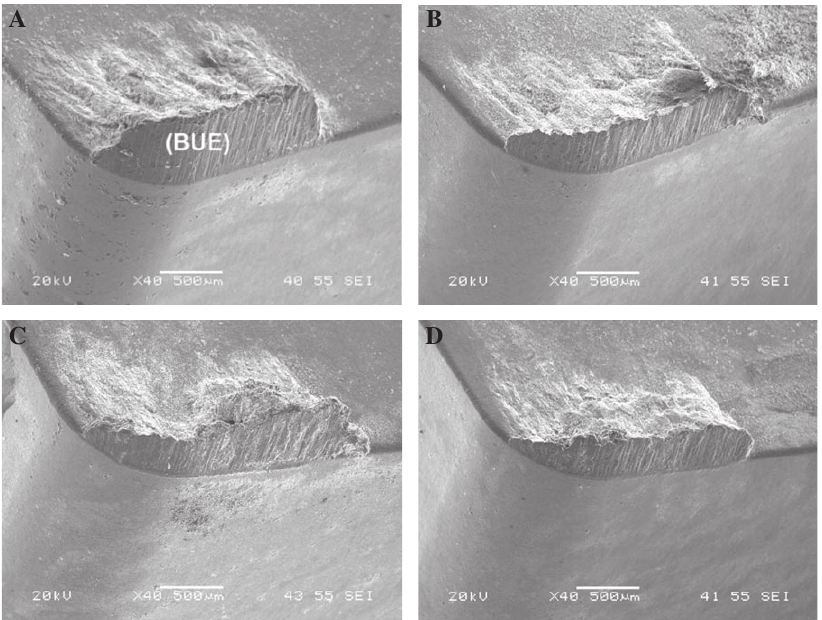
Figure 10 SEM photos of cutting edges in the 10 % MgO reinforced MMC specimen with CC tool at 0.15 mm/rev feed rate and 150 (A), 200 (B), 250 (C) and 300 (D) m/min cutting forces (JEOL JSM-6060 LV, Scanning Electron Microscope, Japan).